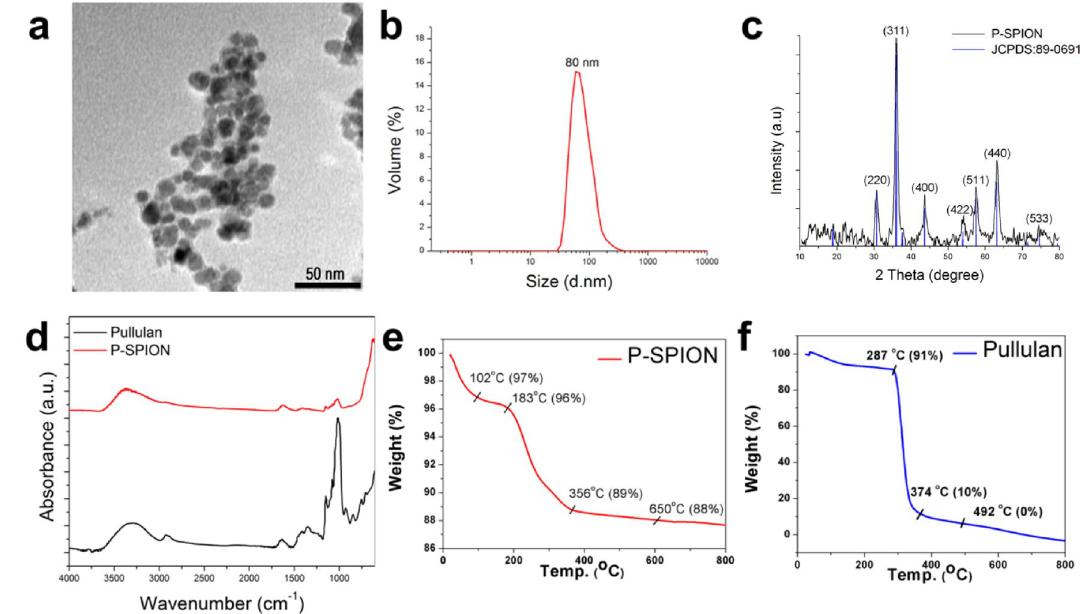
Figure 1. Physico-chemical characterization of P-SPIONs. ( a ) TEM and ( b ) DLS graph of P-SPIONs, ( c ) and ( d ) represent its XRD pattern and FTIR spectra respectively. ( e ) and ( f ) indicates the TGA curves of P-SPIONs and